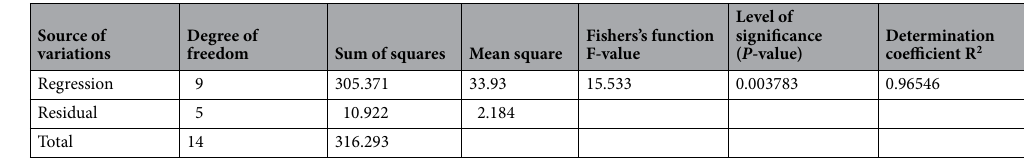
Table 2. Analysis of variance (ANOVA) of the fitted quadratic polynomial